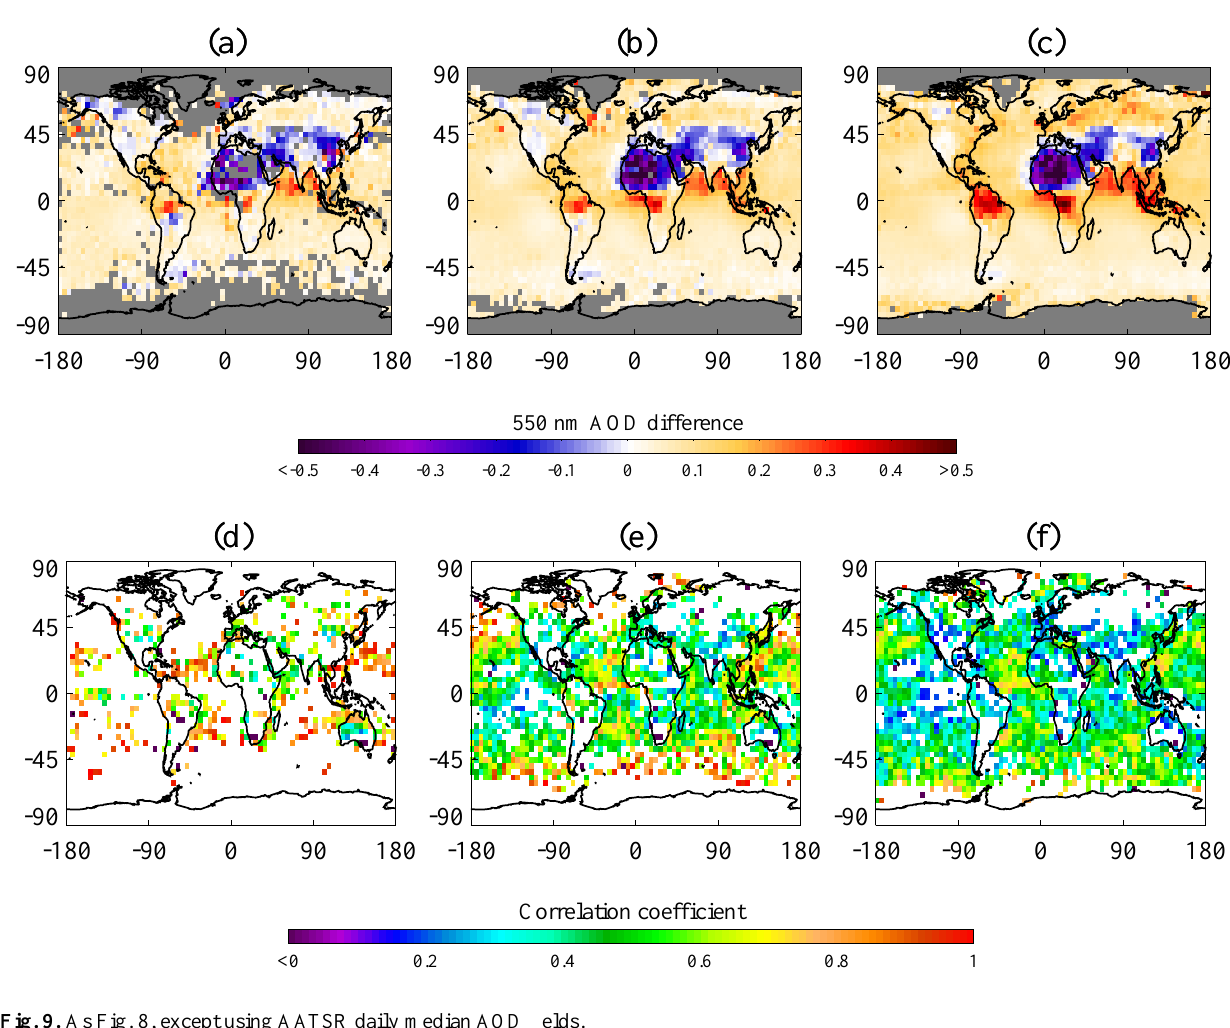
Fig. 9. As Fig. 8, except using AATSR daily median AOD